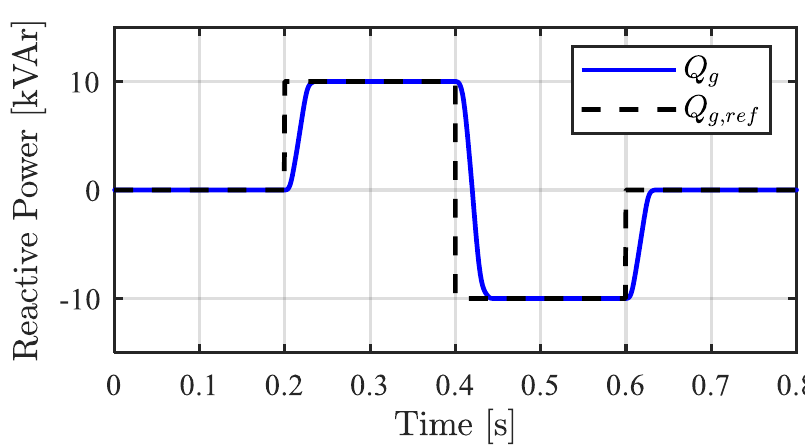
Figure 14. Reactive power to the grid time profile.